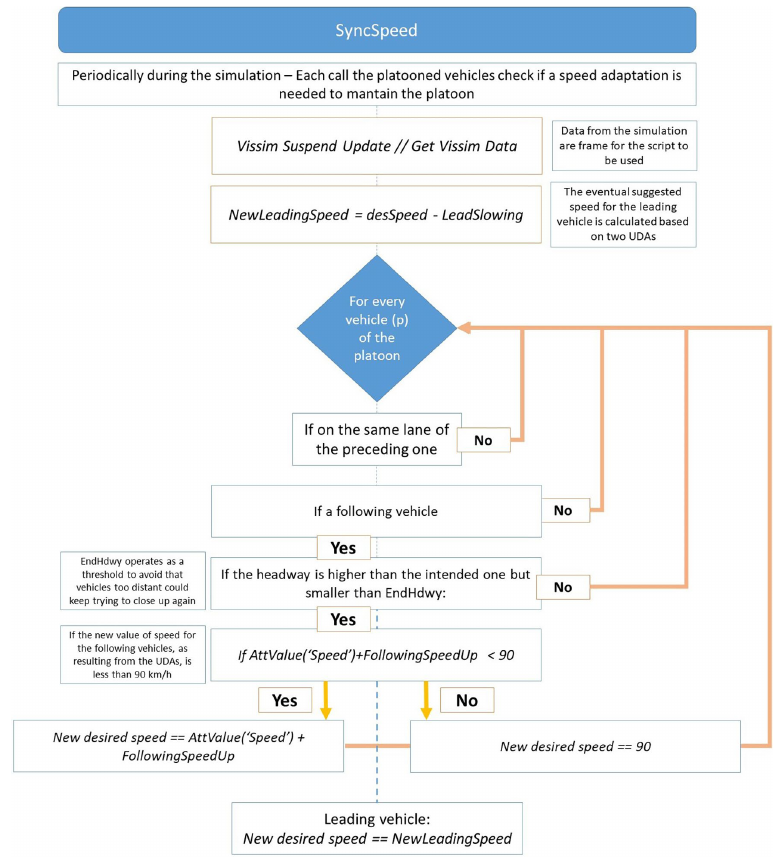
Figure 4. SyncSpeed